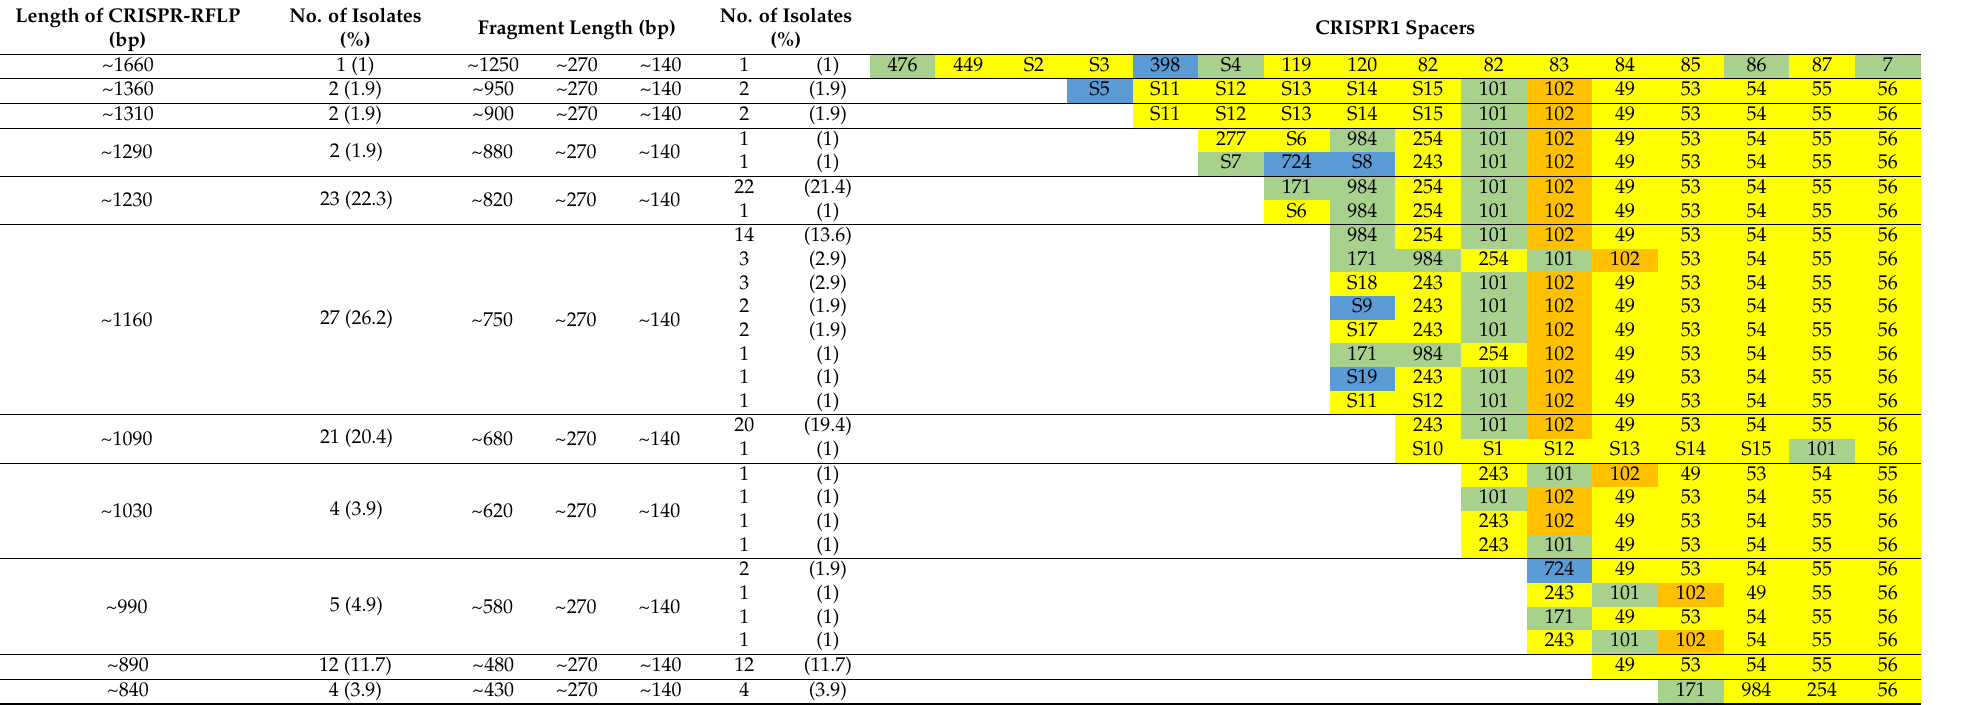
Table 1. Correlation of the CRISPR-RFLP pattern with spacer